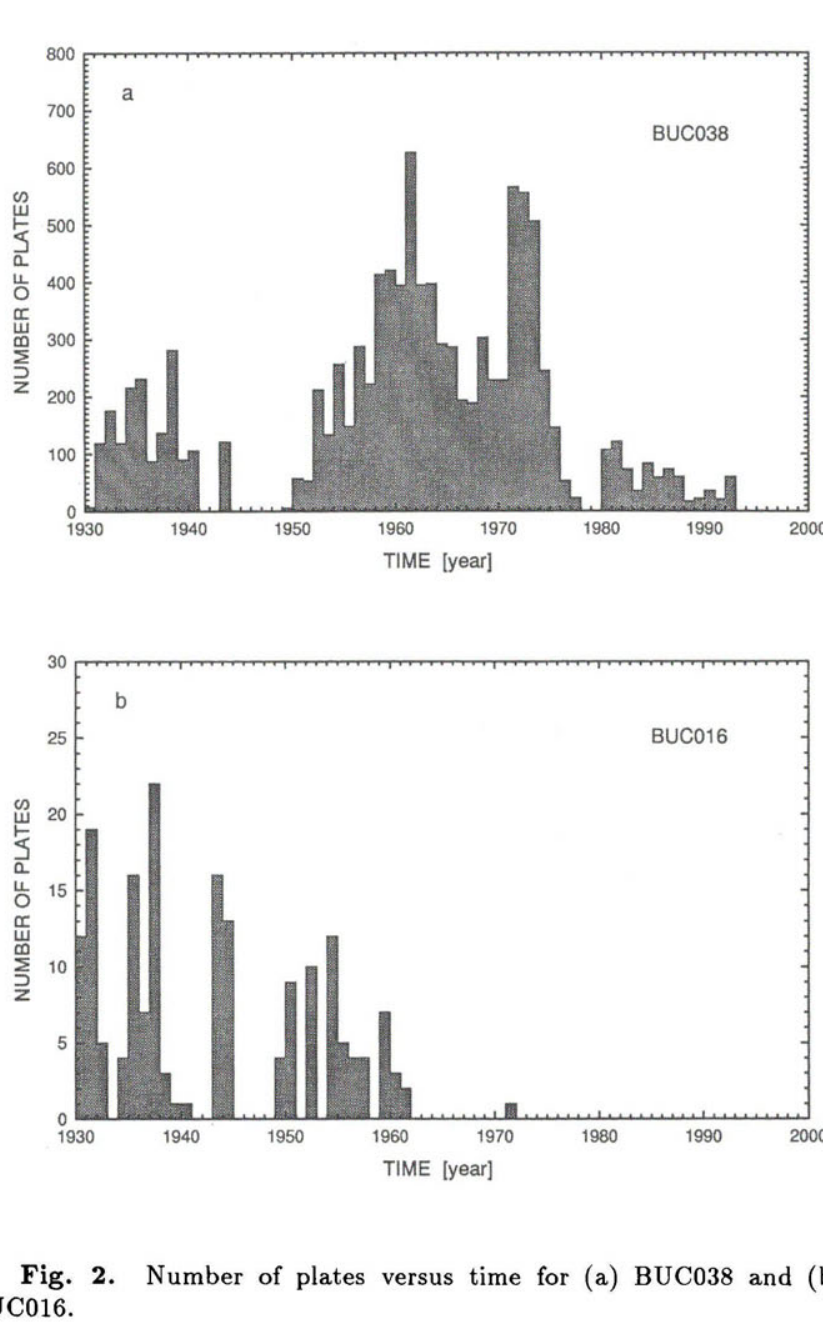
Fig. 2. Number of plates versus time for (a) BUC038 and (b)